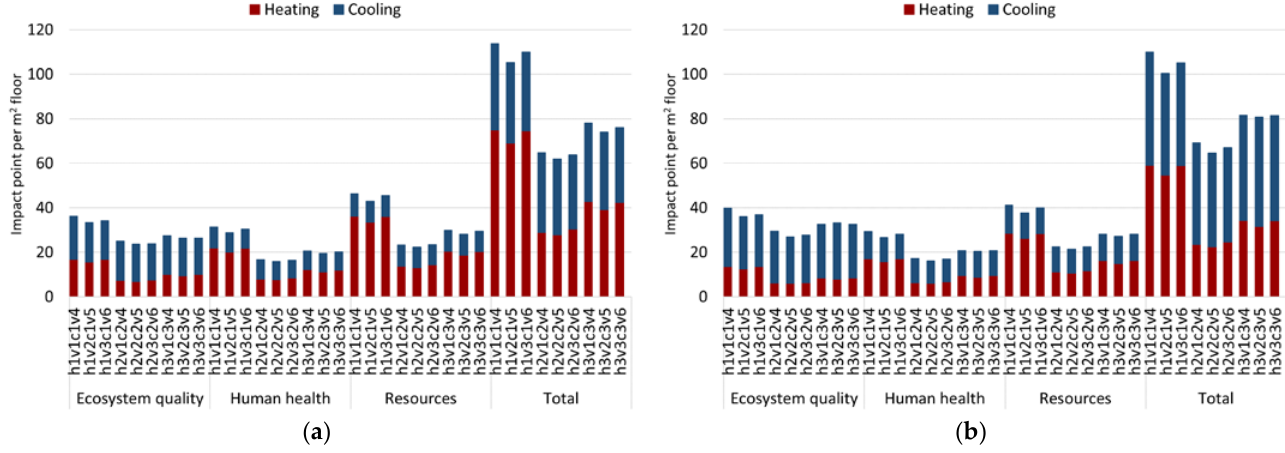
Figure 9. Comparison of the annual results per m 2 of floor area (manufacturing and disposal + operational stage) for heating and cooling using the indicator ReCiPe calculated with: ( a ) LCA b ; and ( b ) LCA cc .